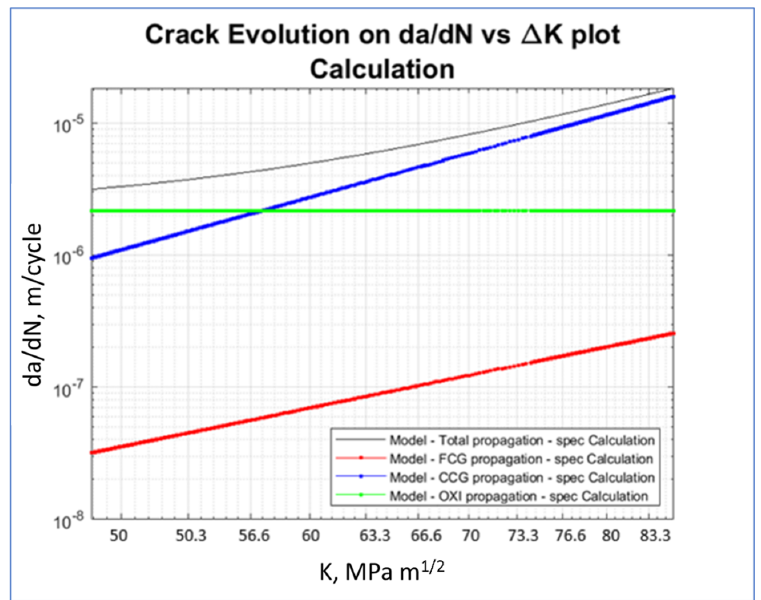
Figure 25. Crack growth evolution in terms of SIFs at an operating cycle of ten firing hours.